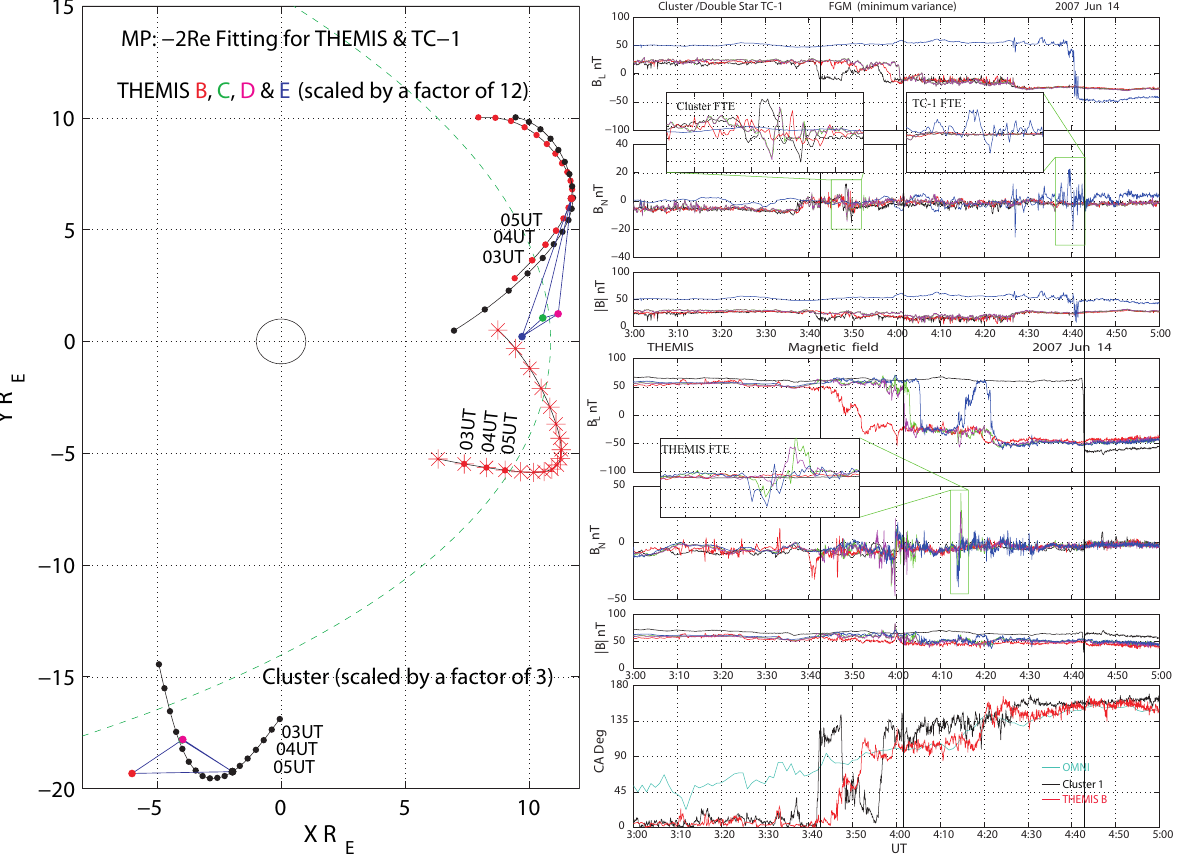
Fig. 2. A coordinated magnetopause encounter of the 5-THEMIS, TC1 and 4-Cluster spacecraft. (a) Shows the spacecraft locations in the equatorial plane (with the 4-Cluster and THEMIS B–E spacecraft configurations indicated), where the time interval of the data plot in (b) is indicated on the orbit segments (drawn for longer time intervals). The dashed line is a cut through a model magnetopause (Sibeck et al. 1991), as indicated. (b) Shows multi-spacecraft, magnetic field data for all 10 spacecraft in boundary normal co-ordinates (where L is aligned to the background field tangential to the magnetopause and n is the magnetopause normal). Only the field magnitude and the N and L components are shown here. The colours used to indicate each spacecraft are: black, red, green, and magneta, for Cluster 1–4 and THEMIS A–D, and blue for both TC-1 and THEMIS-E. The lower panel on the right hand plot shows the clock angle (the angle of the IMF in the Y,Z plane, measured from Z ), calculated for Cluster 1 (in the magnetosheath continually after 04:00UT), THEMIS B (in the magnetosheath after 03:50UT) and the OMNI data. The insets show zoomed time intervals for the selected FTEs to better show the signatures in these